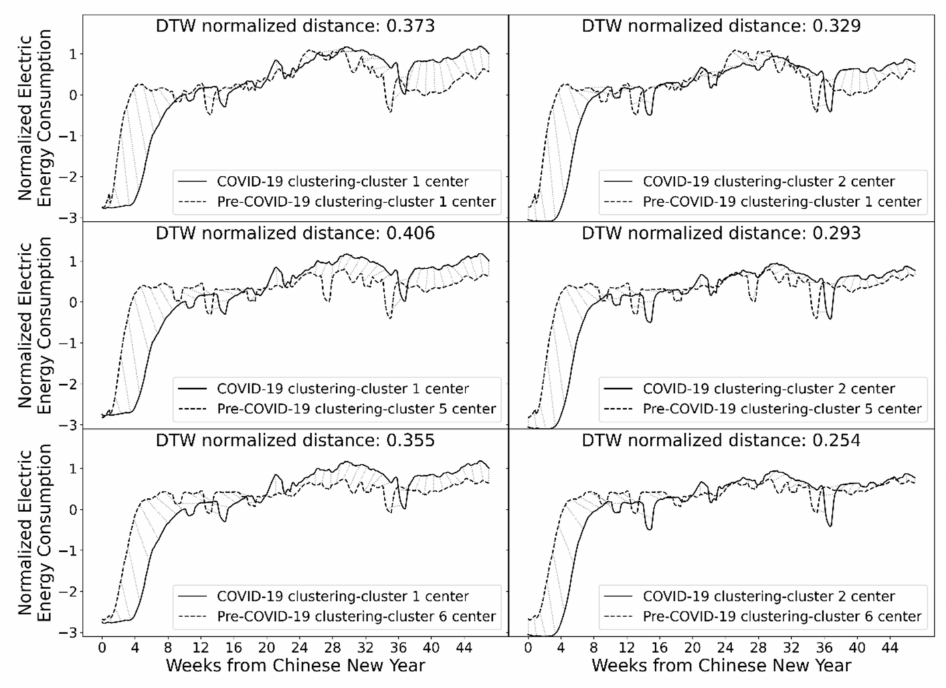
Figure 15. Dynamic time warping (DTW) comparison between the cluster centers of the COVID-19 clustering and pre-COVID-19 clustering (moving average filtering with the filtering window length 7 is applied to the cluster